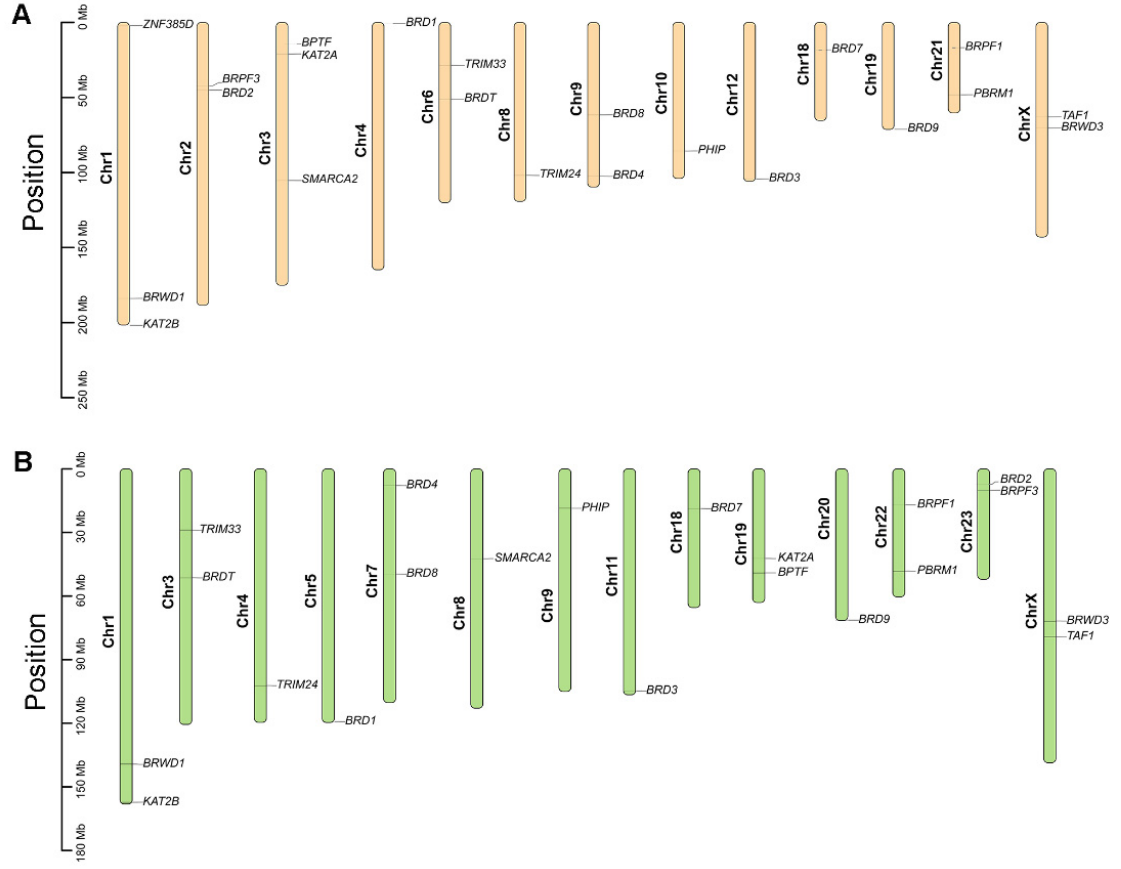
Figure 4. Chromosomal distribution of BRD genes in buffalo and cattle. ( A ) Position of BRD gene on buffalo chromosome. ( B ) Position of BRD gene on cattle chromosome. The ellipses, which are marked with orange and green colors, represent buffalo and cattle chromosomes, respectively.